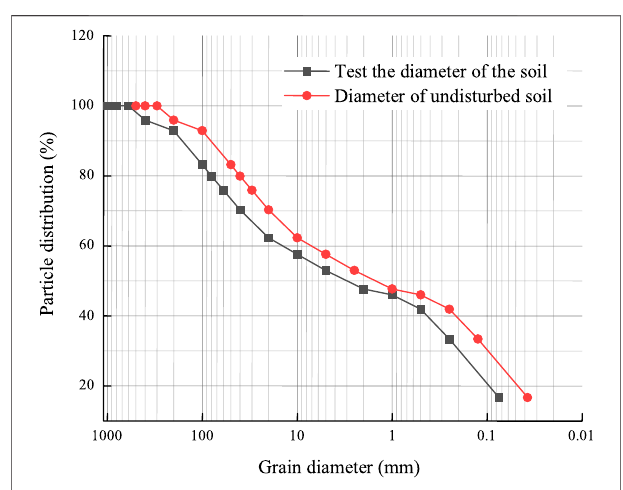
FIGURE 2 | Gradation curve of gravel slag and sand-soil mixture diagram.